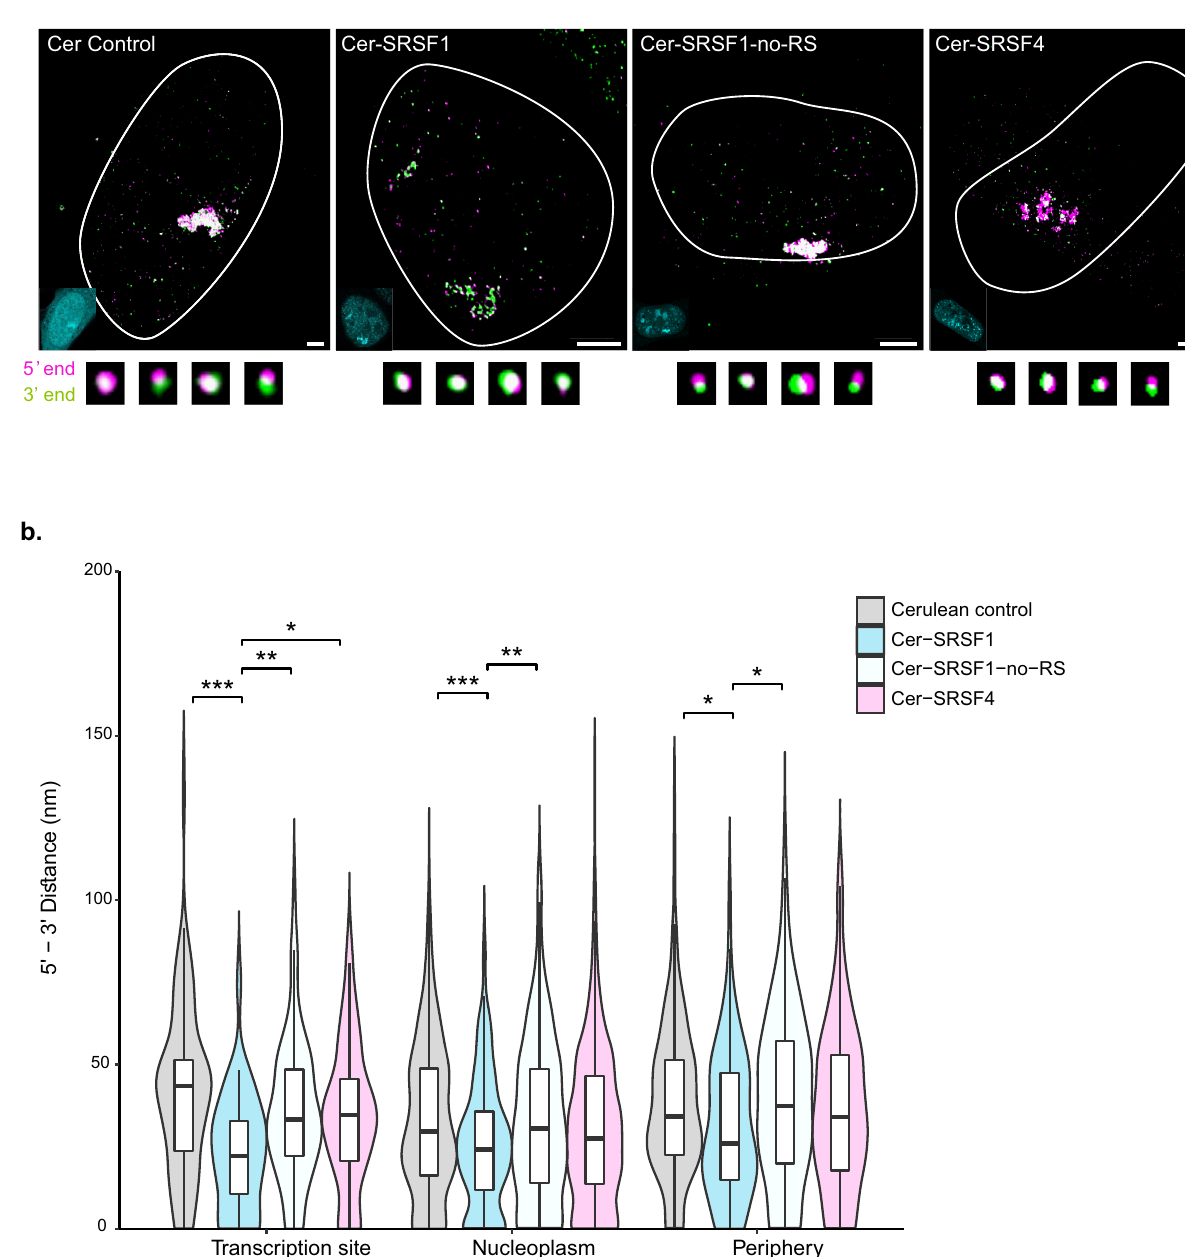
Fig.2|TheeffectsofSRoverexpressiononmRNAcompaction.a Representative